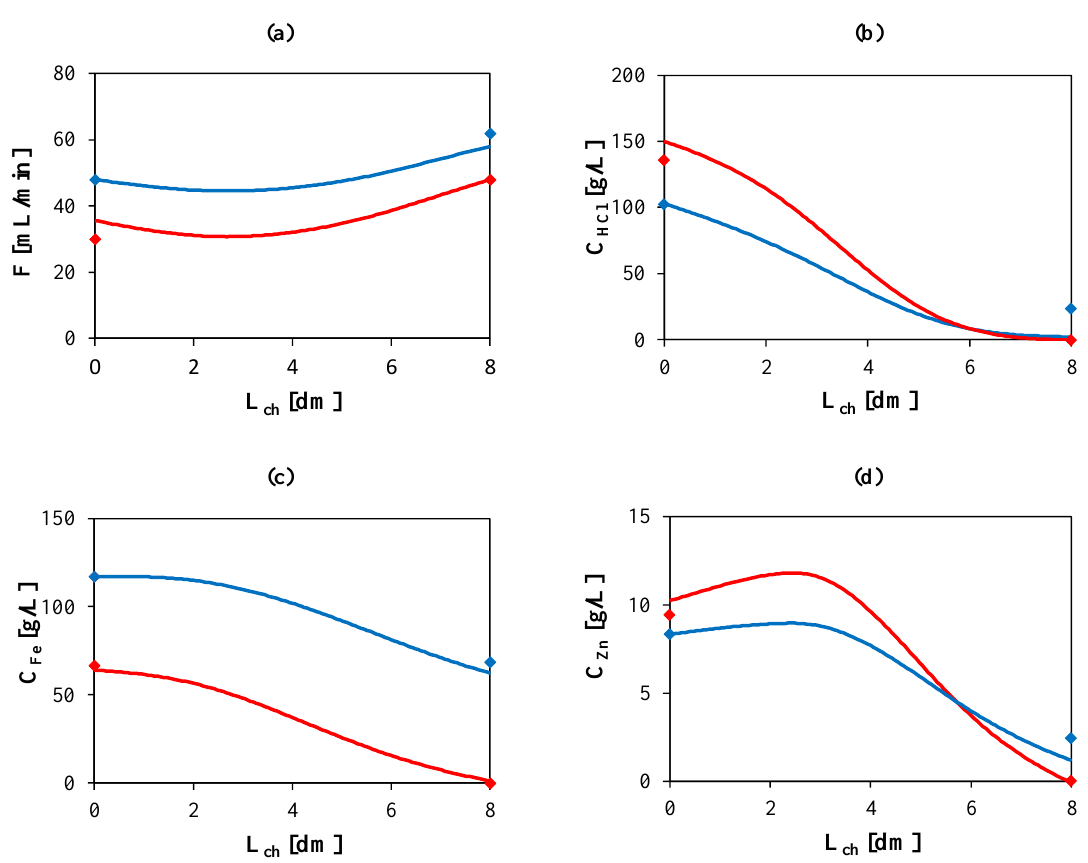
Figure 7. Flow rate ( a ), HCl concentration ( b ), Fe concentration ( c ) and Zn concentration ( d ) vs. channel length for retentate (blue) and diffusate (red) for the continuous test 4 named in Table 2. Theoretical curves (—) obtained by using the model. Experimental data (dots).